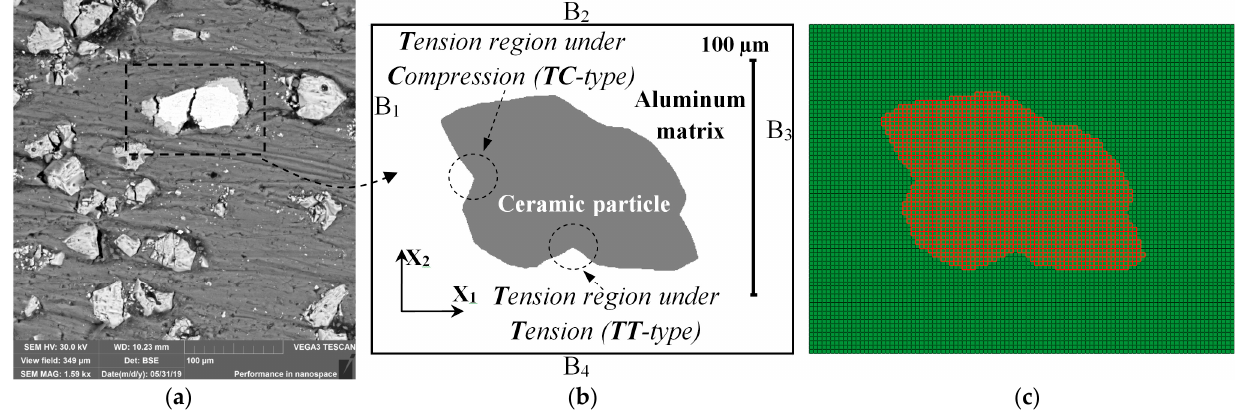
Figure 1. Experimental ( a ) and model structure of a metal-matrix composite ( b ) and corresponding 100 × 78 fi nite element voxel mesh ( c ).